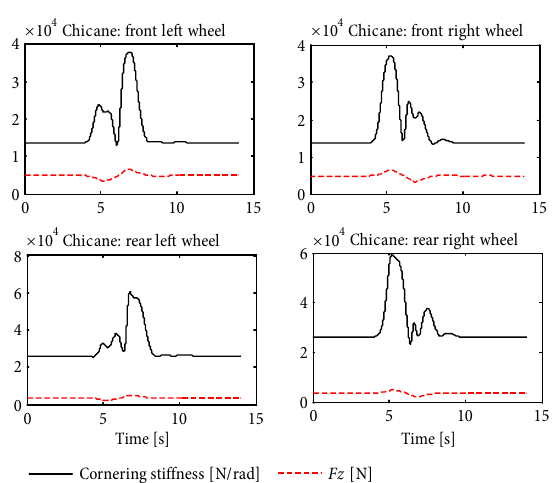
Fig. 3. Cornering Stiffness and tires’ vertical forces – chicane